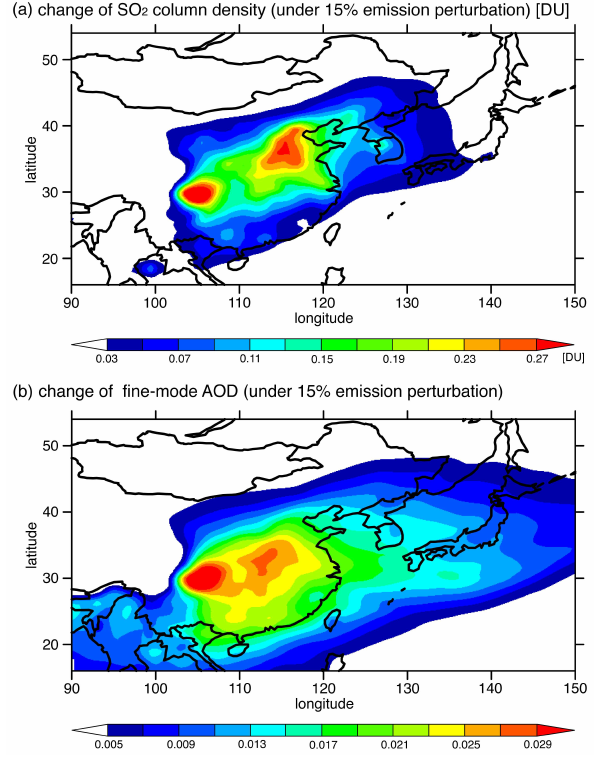
Fig. 5. Spatial distribution of (a) the change in SO 2 VCD and (b) AODf under a 15% perturbation in emissions, 1E